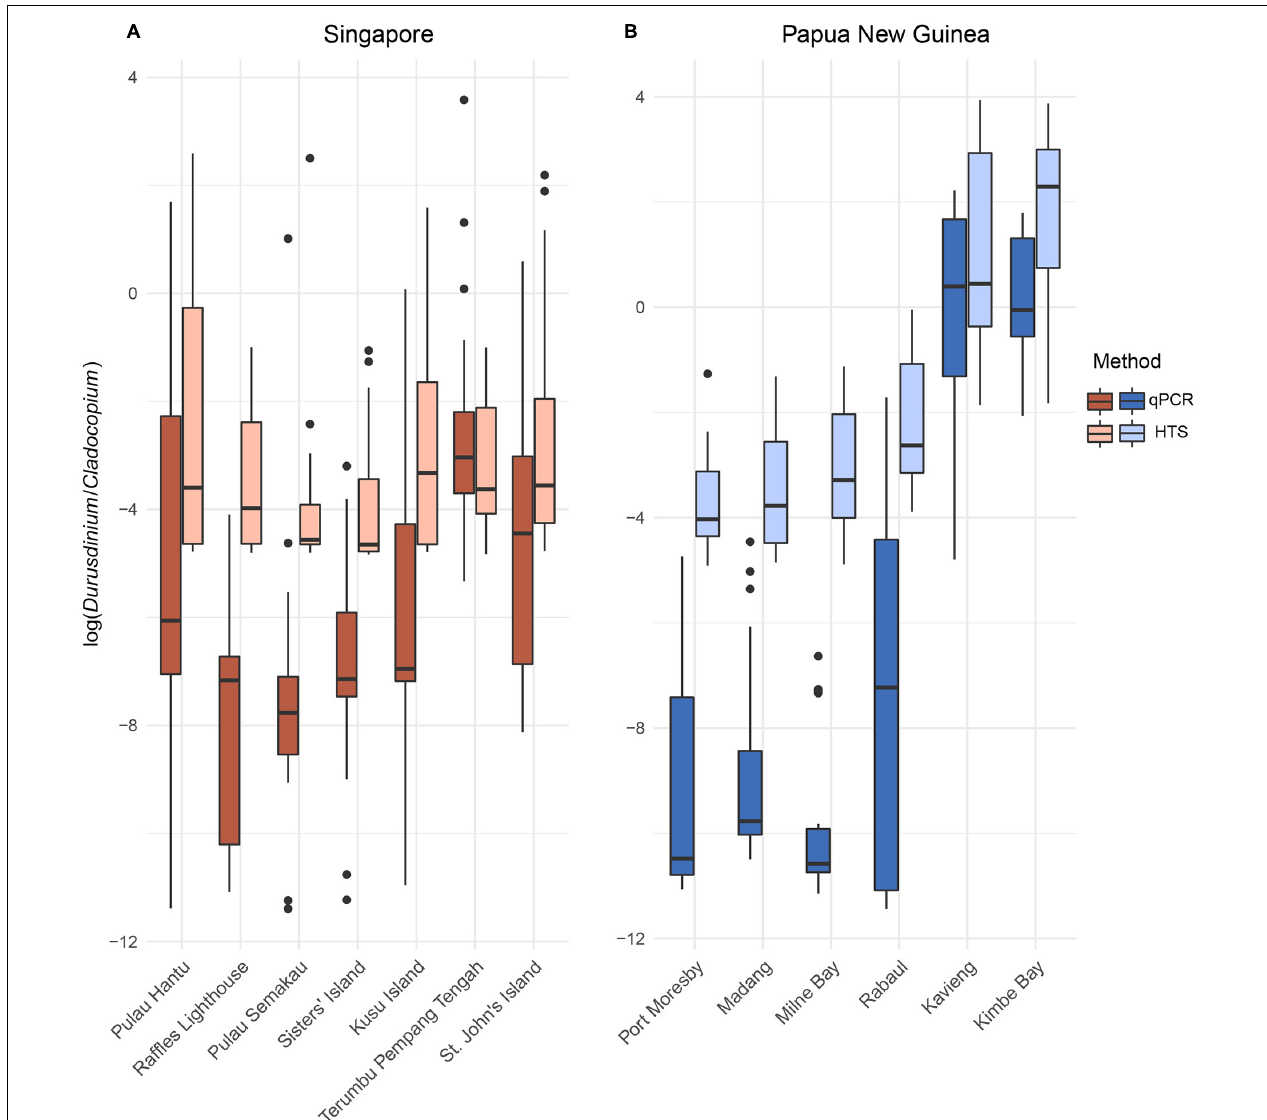
FIGURE 2 | Ratios of Durusdinium vs. Cladocopium relative abundances (log-transformed ratios) in the (A) seven sites across Singapore and (B) six sites across Papua New Guinea obtained via quantitative polymerase chain reaction (qPCR) and high-throughput sequencing (HTS).